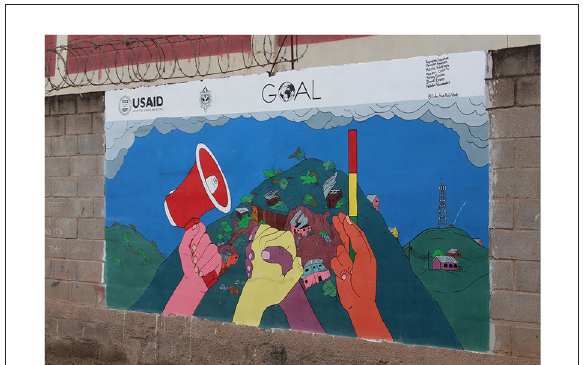
FIGURE10 A mural showing landslide damage to a settlement (background) with a megaphone, gripping hands, and the colored alert levels from the EWRS (foreground). Credit: GOAL,